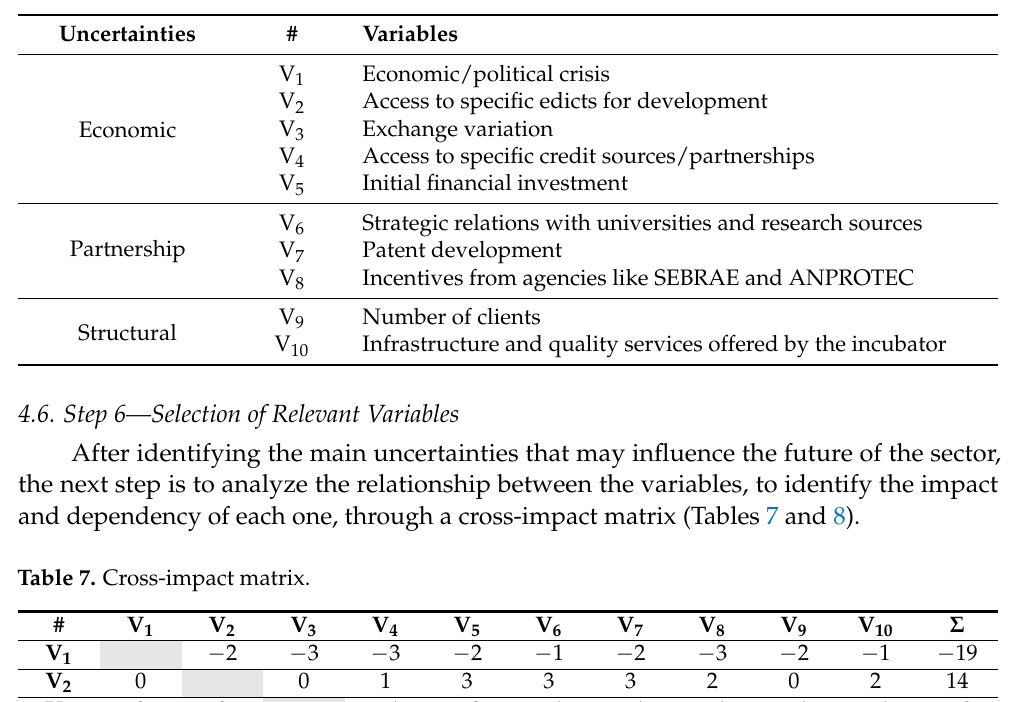
Table 6. Uncertainties and variables.